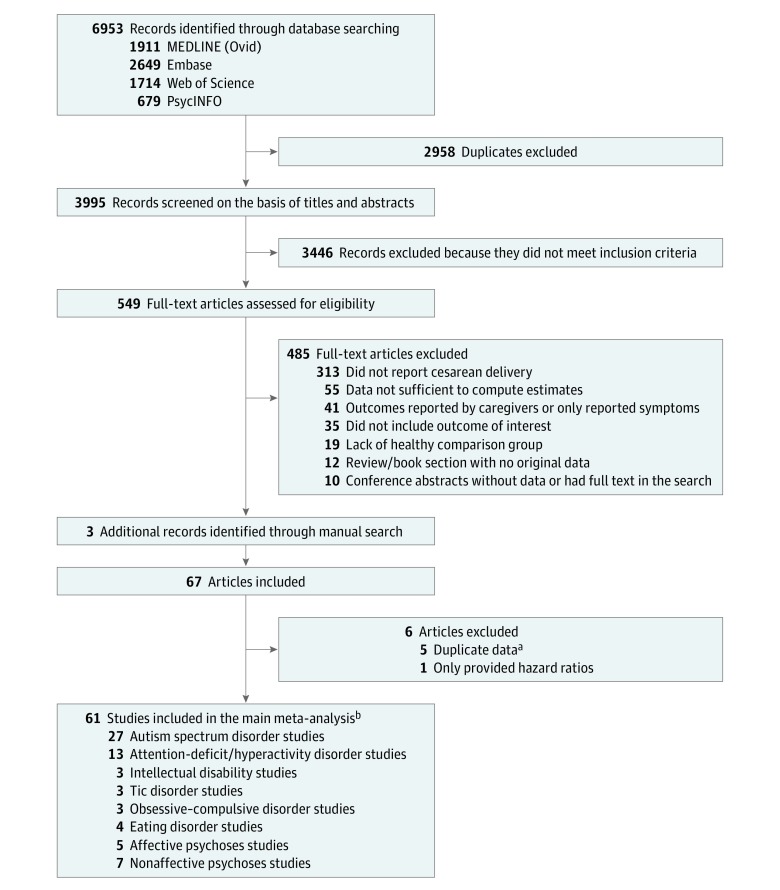
Preferred Reporting Items for Systematic Reviews and Meta-analyses (PRISMA) Flow DiagramaCharacteristics of these studies are presented in eTable 2 in the Supplement.bSome studies address associations with more than 1 outcome.